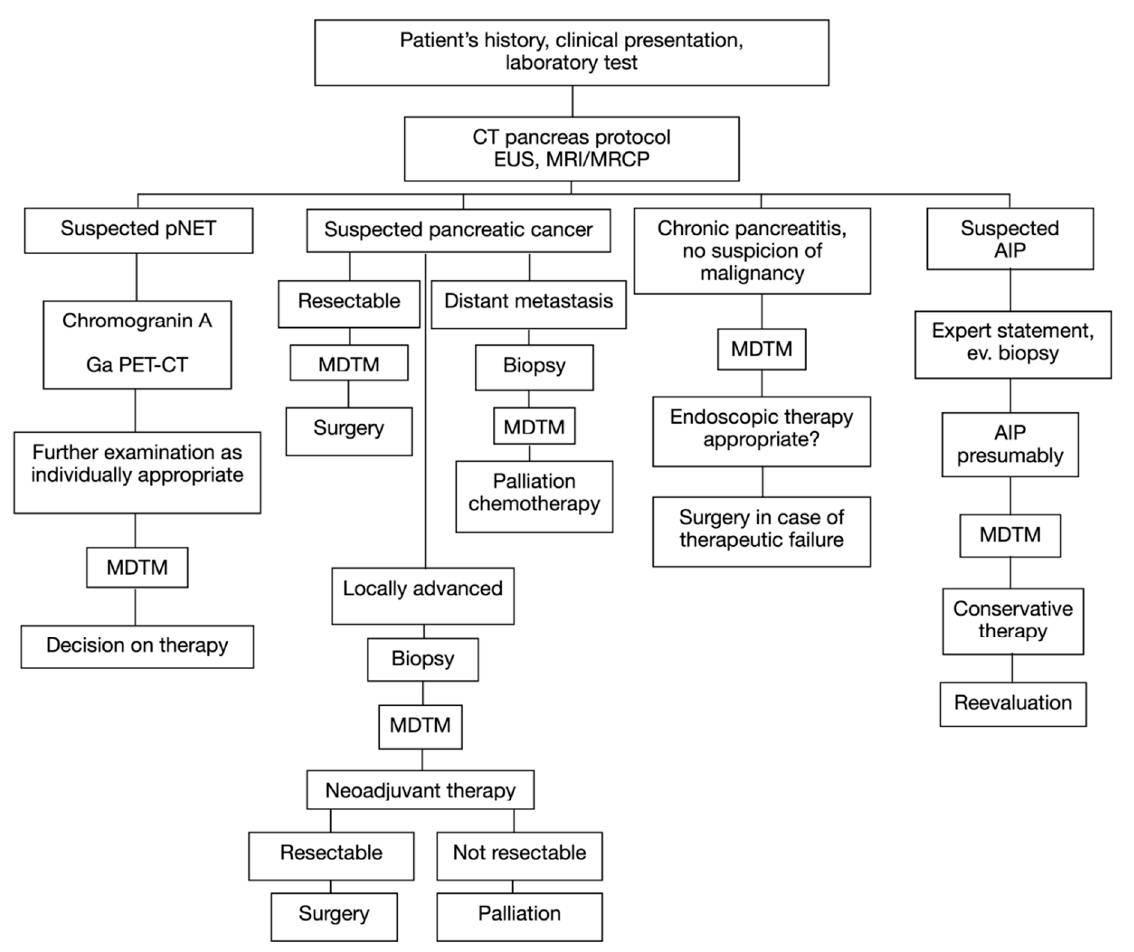
Figure 2. Diagnostic algorithm of a patient with a solid pancreatic mass. EUS = endoscopic ultrasound; MRI = magnetic resonance imaging; MRCP = magnetic resonance cholangiopancreatography; NET = neuroendocrine tumor; AIP = autoimmune pancreatitis; Ga PET-CT = Gallium-positron emission computed tomography; MDTM = multidisciplinary team meeting.